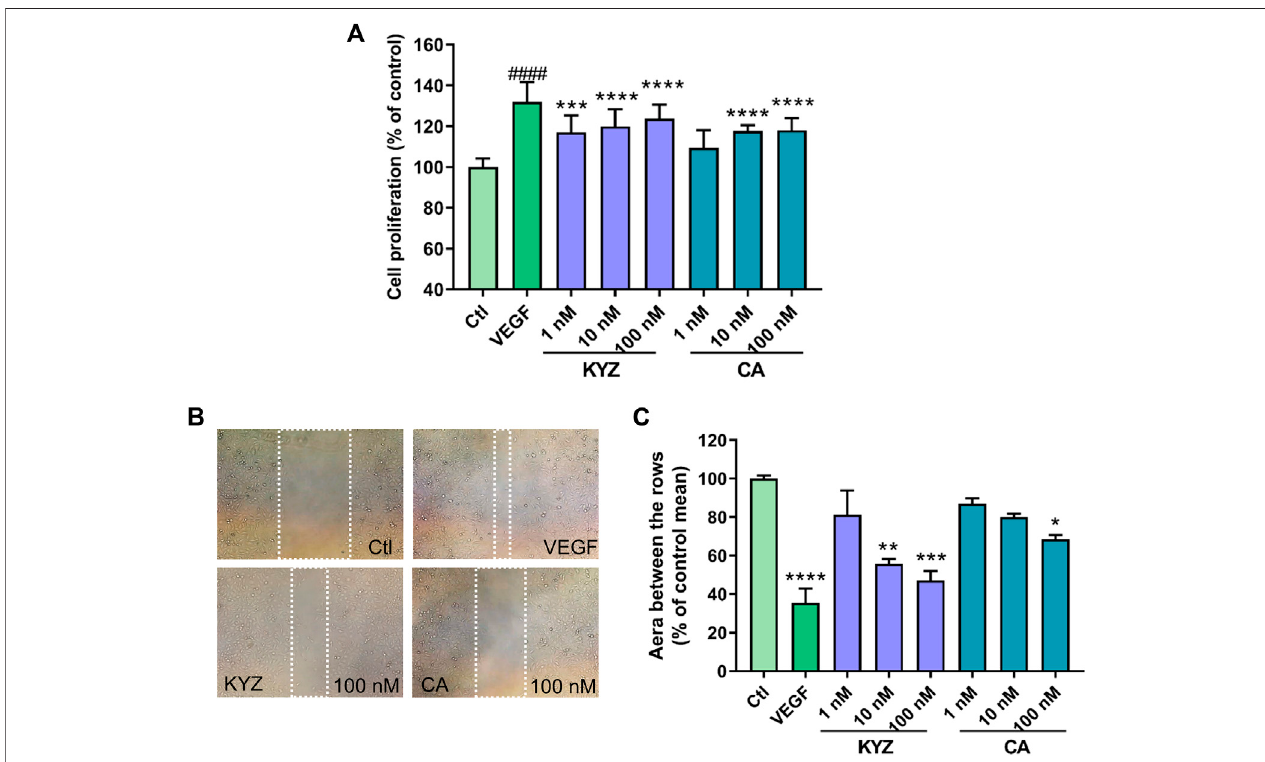
FIGURE5| KYZandCAtreatmentpromotedHUVECsproliferationandenhancedrepairwoundability (A) HUVECswereculturedin96-wellmicroplates(2.5×10 3 cells/100 µl).Aftertreatment for12 h, theculturemedium wasremovedandwasreplacedwithmedium without FBAforstarvation, thenHUVECsweretreated withKYZ and CA. After treatment for 24 h, cell proliferation was measured by CCK-8 assay. (B) HUVECs were scratched using pipette tips to induce the wound. The white area indicatedthesizeofthewound after treatment withthe KYZand CAfor24 h. Thephotomicrographswereshown at ×10magni fi cation. (C) Quantitative analysisof the scratch area of HUVECs (the area between two white line) by ImageJ software. The scratch area of the control group was de fi ned as 100%. Results were shown as mean ± SEM. One-way ANOVA was used for statistical analysis. * p < 0.05,** p < 0.01,*** p < 0.001,**** p < 0.0001 vs. control.